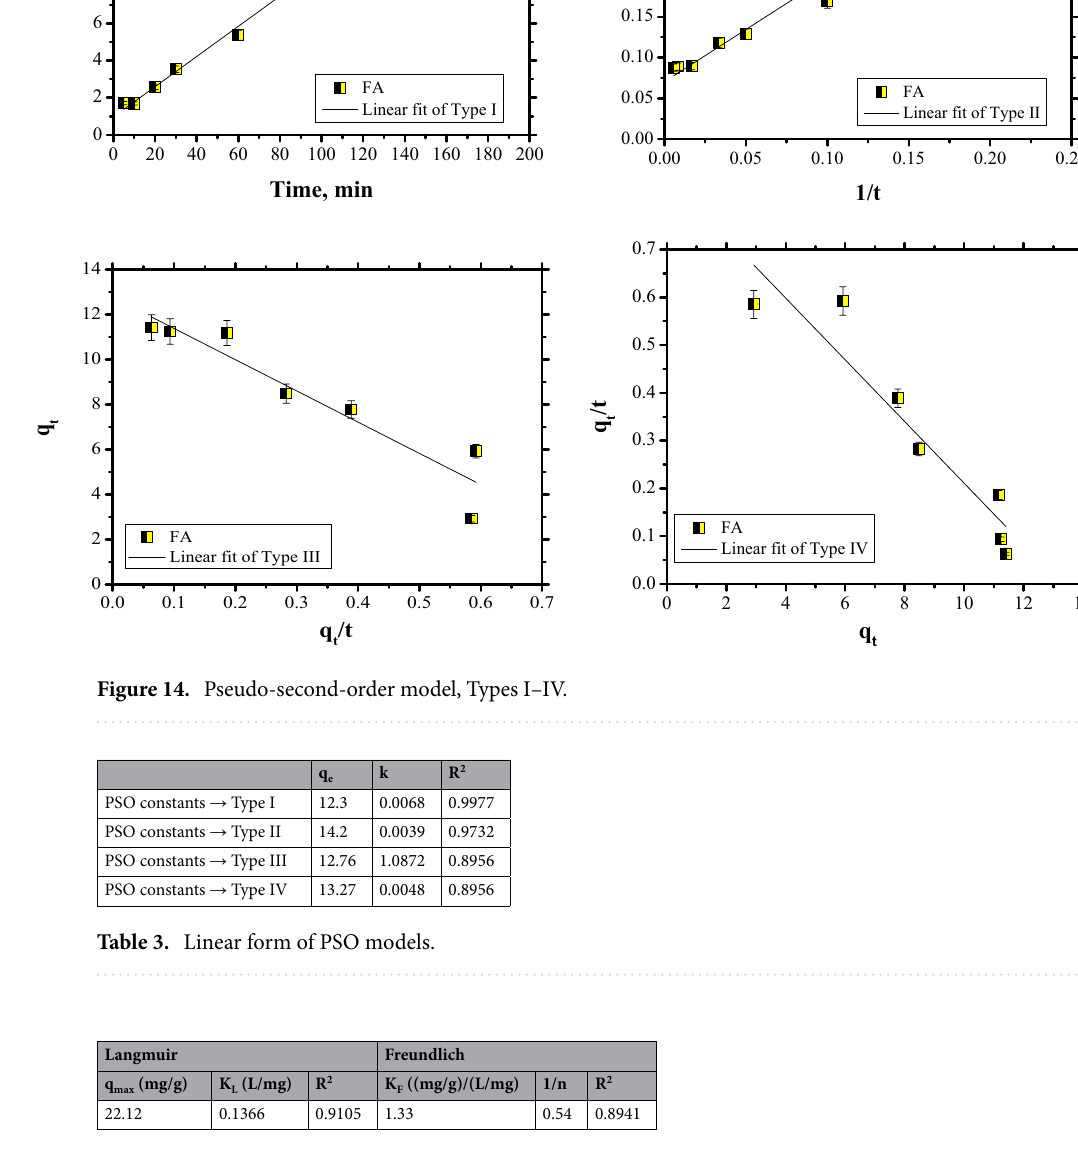
Table 4. Parameters for Langmuir and Freundlich